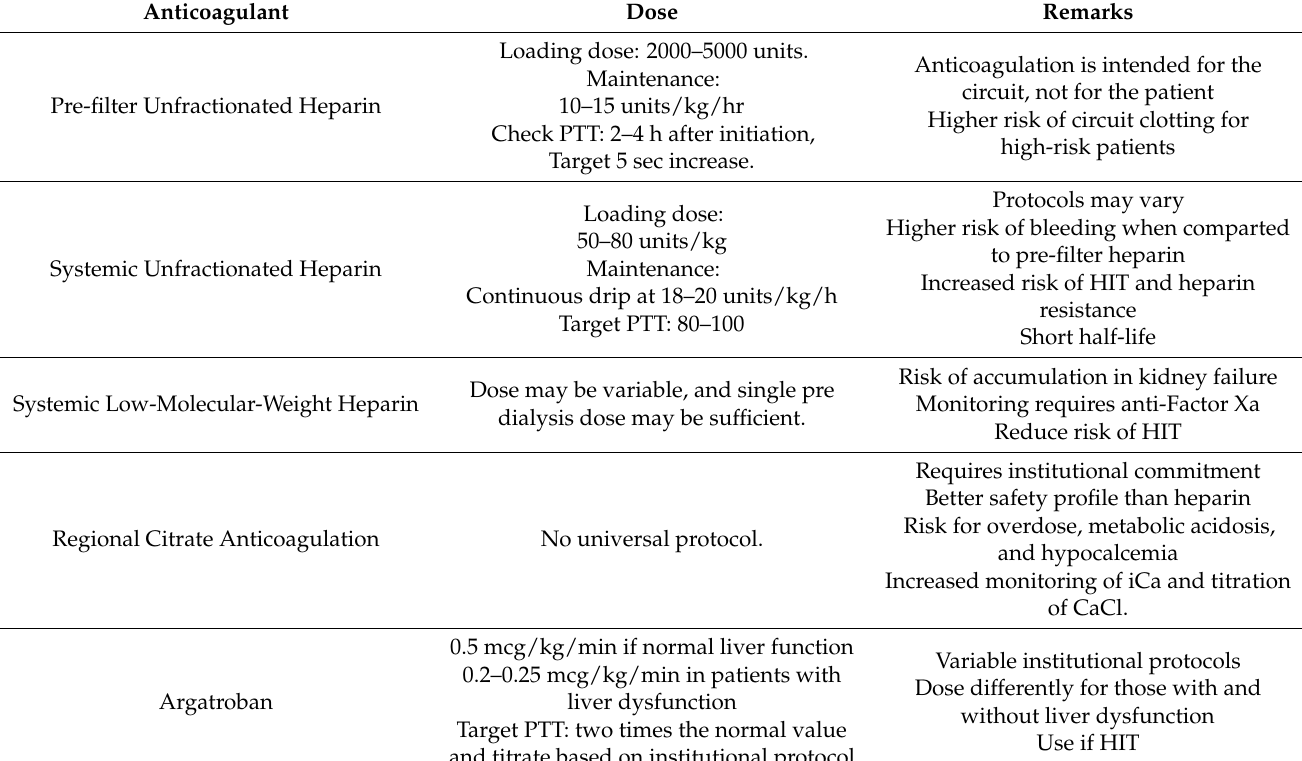
Table 4. Anticoagulation Strategies for kidney replacement therapy (KRT) in CoV-AKI. Anticoagulation strategies in KRT adopted from recommendations given by a panel of experts from the American Society of Nephrology (ASN) in their webinar on April 2020, along recommendations from 2012 Kidney Disease Improving Global Outcomes (KDIGO) guidelines.